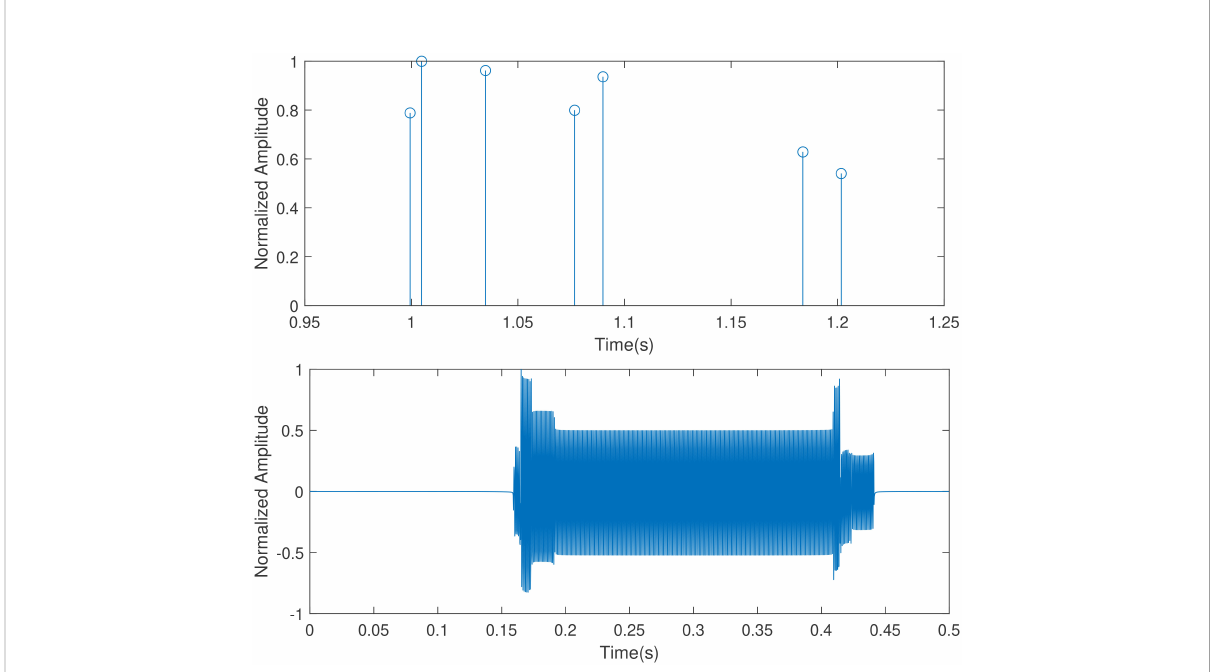
FIGURE 3 Multipath signals using BELLHOP. The picture above is underwater impulse responses with amplitudes and delays, and the picture below is received underwater multipath